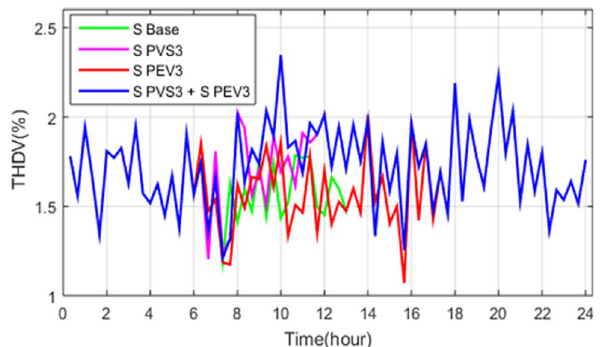
Figure 17. Analysis of daily pro fi les of THD difference when random value of medium voltage grid and PEV harmonic.